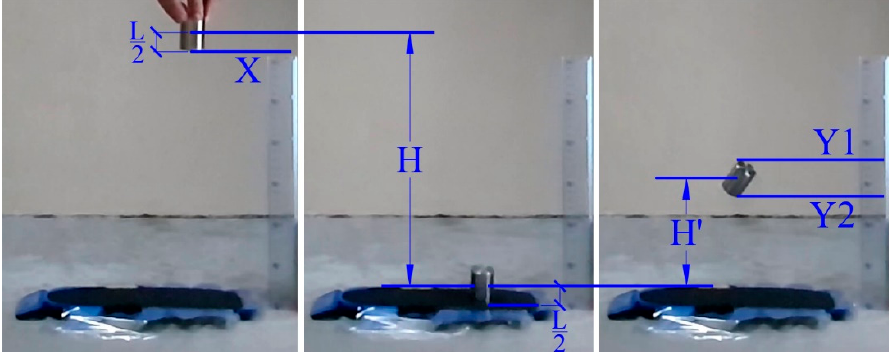
Figure 11. Illustration of rebound test. ( Left ) Pre-release of cylindrical steel mass; ( middle ) Normal direction impact; ( right ) At maximum rebound height.